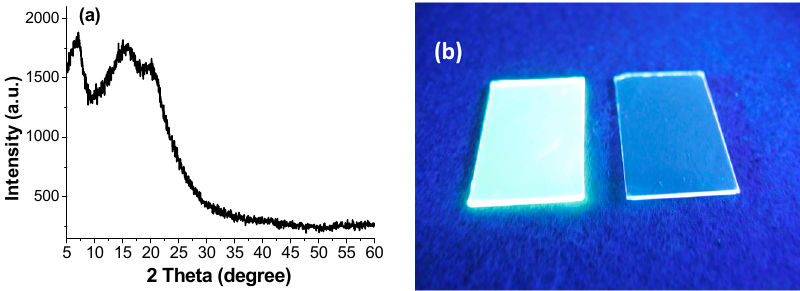
Figure 2. ( a ) XRD spectra of the solution drop-casting thin film of SimCP3 on silicon wafer; ( b ) PL images of solution spin-coated thin films of SimCP3 : FIrpic (~10 wt %) and SimCP3 .